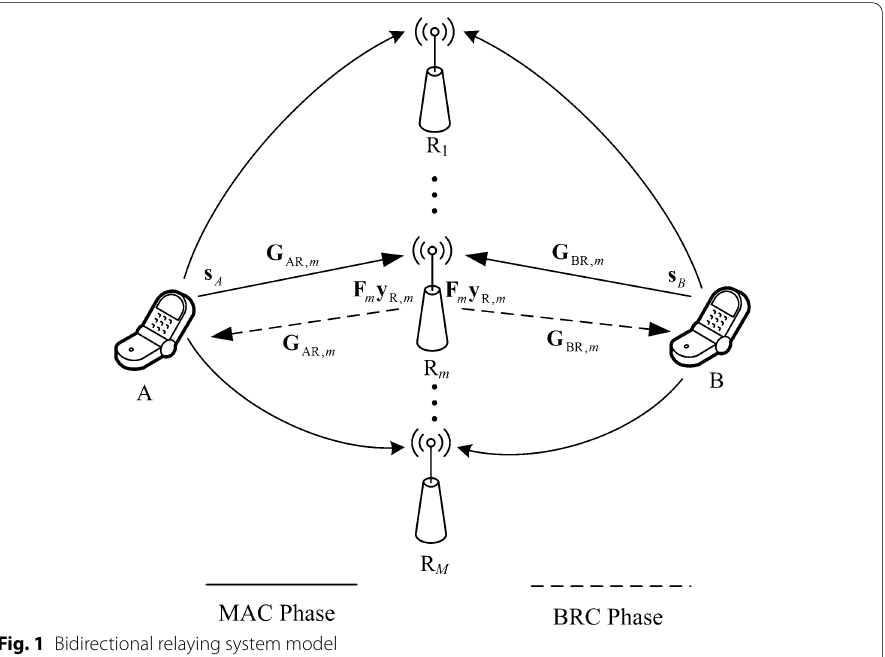
Fig. 1 Bidirectional relaying system